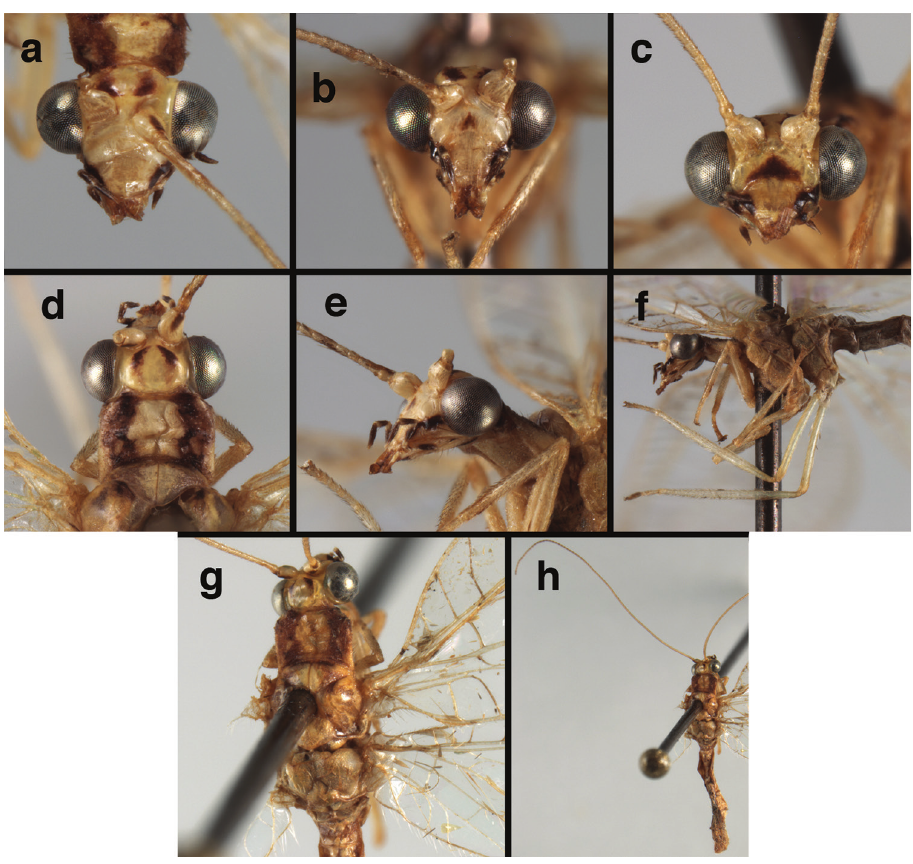
Figure 38. Ungla favrei (Navás): External features, ( a, b, c ) head, frontal [Note variation in markings.] ( d ) head, prothorax, anterior mesothorax, dorsal ( e ) head, lateral ( f ) thorax, lateral ( g ) head, thorax, dorsal ( h ) body, dorsal (all: Bolivia, Cochabamba, CAS; a male; b–h female). : 1), 10–11 radial cells, 3 Banksian (b) cells, 4 b’ cells, 4–5 inner gradates, 5–6 outer